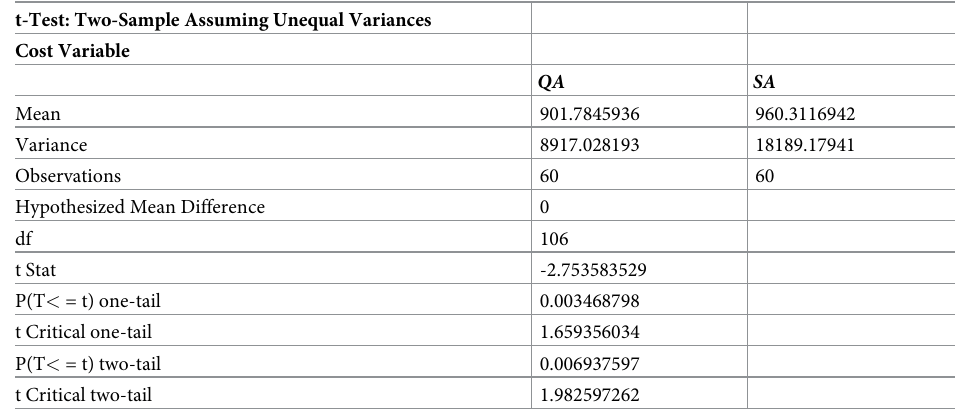
Table 20. T-test for n = 50 nodes and N = 60 trials–total distance cost variable.